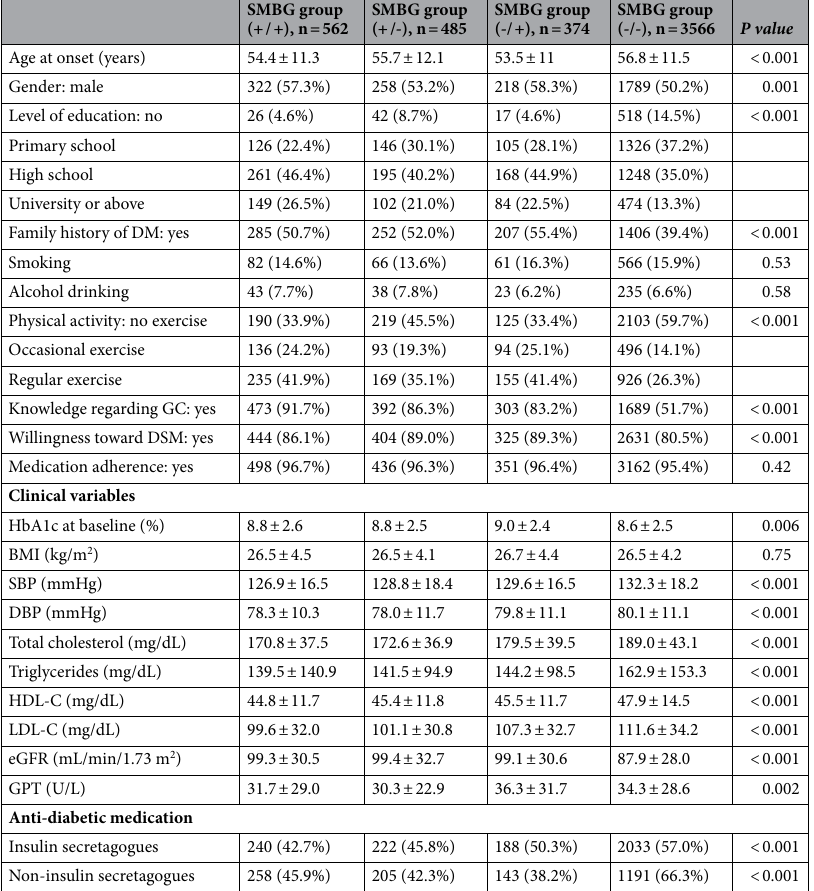
Table 1. Basic characteristics of participants (n = 4987) in each SMBG group. Results are expressed as mean ± SD or n (%). SMBG, self-monitoring of blood glucose; SD, standard deviation; DM, diabetes mellitus; GC, glycemic control; DSM, diabetes self-management; HbA1c, hemoglobin A1c; BMI, body mass index; SBP, systolic blood pressure; DBP, diastolic blood pressure; HDL-C, high-density lipoprotein cholesterol; LDL-C, low-density lipoprotein cholesterol; eGFR, estimated glomerular filtration rate; GPT, glutamic pyruvic